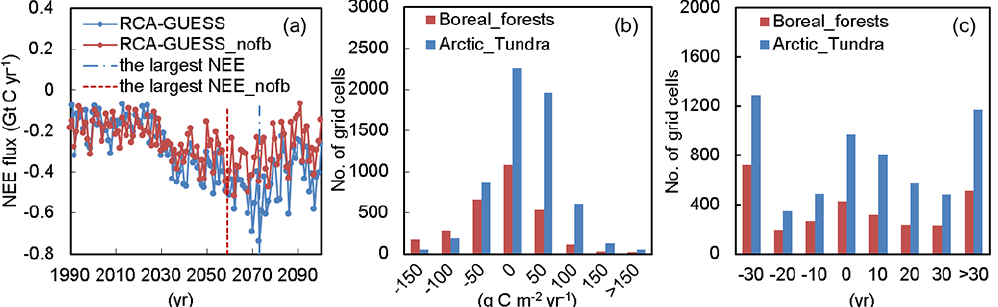
Figure 9. (a) The inter-annual variation of NEE flux (GtCyr − 1 ) in both RCA-GUESS feedback and non-feedback runs from 1990 to 2100 for Arctic tundra. (nofb: the non-feedback run; negative value: carbon sink; the vertical dash and dash-dot lines denote the year with the largest NEE over the whole period). (b) Distribution of the number of grid cells (total: 9032) for the shift of the peak C-uptake rate (gCm − 2 yr − 1 ) in both boreal forests and Arctic tundra (positive: increase; negative: decrease). (c) Distribution of the number of grid cells for the shift of the year (yr) with the peak C-uptake rate in both boreal forests and Arctic tundra (positive: delay; negative: advance). Table 2. Carbon budget of the Arctic tundra and CORDEX-Arctic domains simulated by RCA-GUESS for the period 1990–2100. Accumulative C flux (GtC) C stores (GtC) Domains NPP RH NEP FIRE NEE VegC LittC SoilC Arctic tundra fb. 1 − 302.1 257.7 − 44.4 8.8 − 35.6 33.9 0.5 1.2 Arctic tundra nf. 2 − 288.9 251.8 Arctic tundra diff. 3 CORDEX-Arctic fb. − 541.2 474.5 − 66.7 28 − 38.7 46.9 CORDEX-Arctic nf. − 525.3